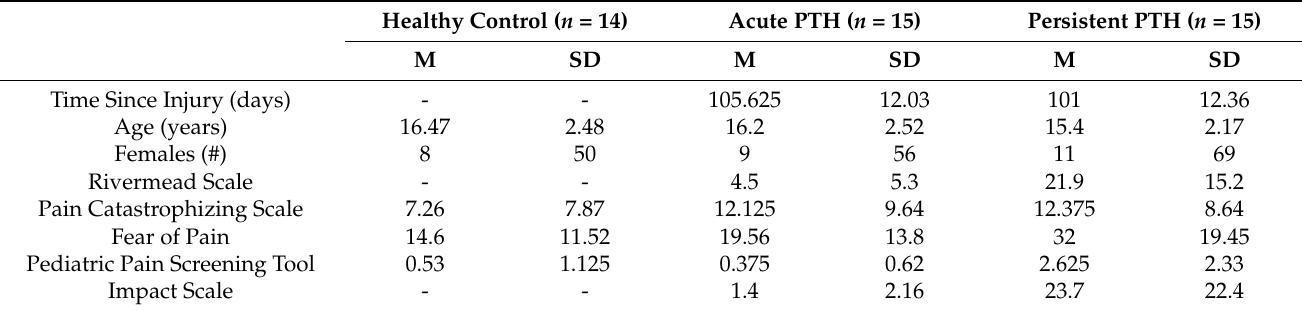
Table 1. Participant demographics. An overview of participant demographics is provided, outlining participant characteristics as well as mTBI-related characteristics.